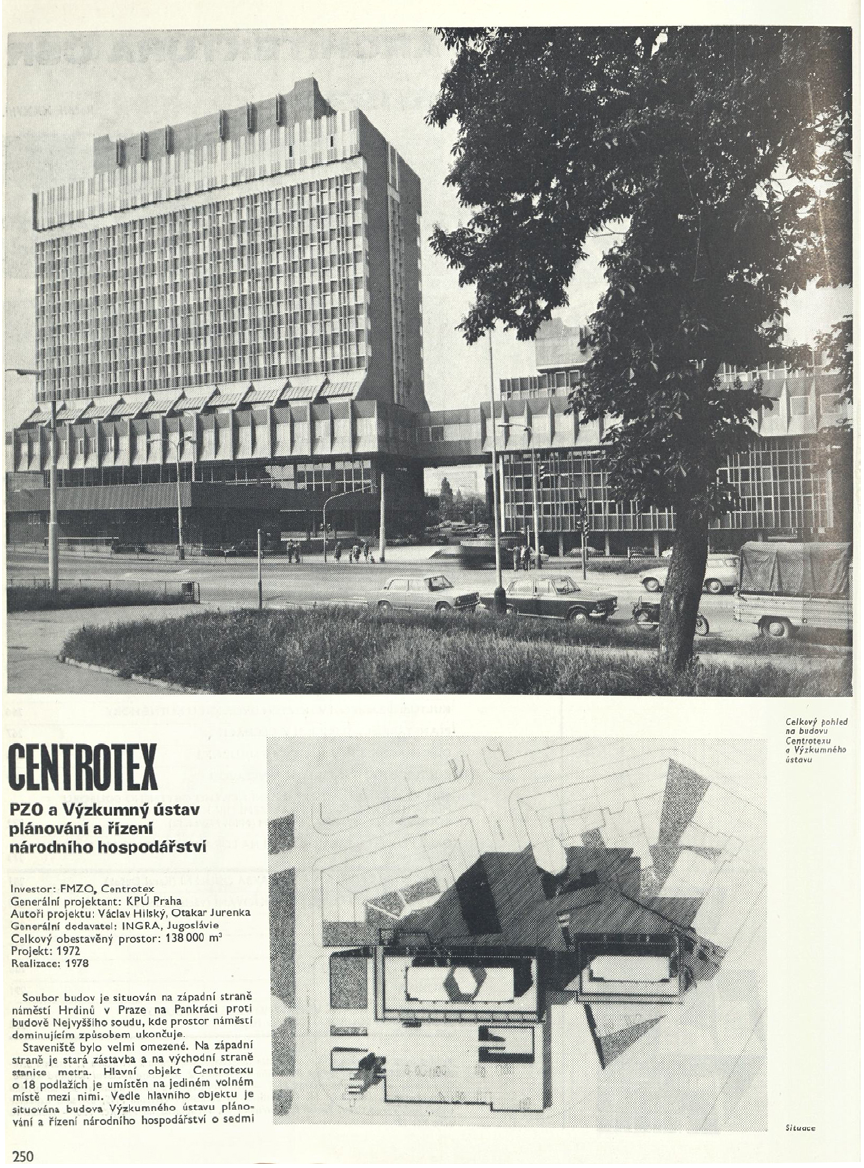
Fig. 8 Architects Václav Hilský and Otakar Jurenka, Centrotex Building, Prague, 1972-1978 In- vestor: FMZO, Centrotex. Con- struction: Ingra Association, Zagreb. (Source: Architektura ČSR no. 6 (1979):